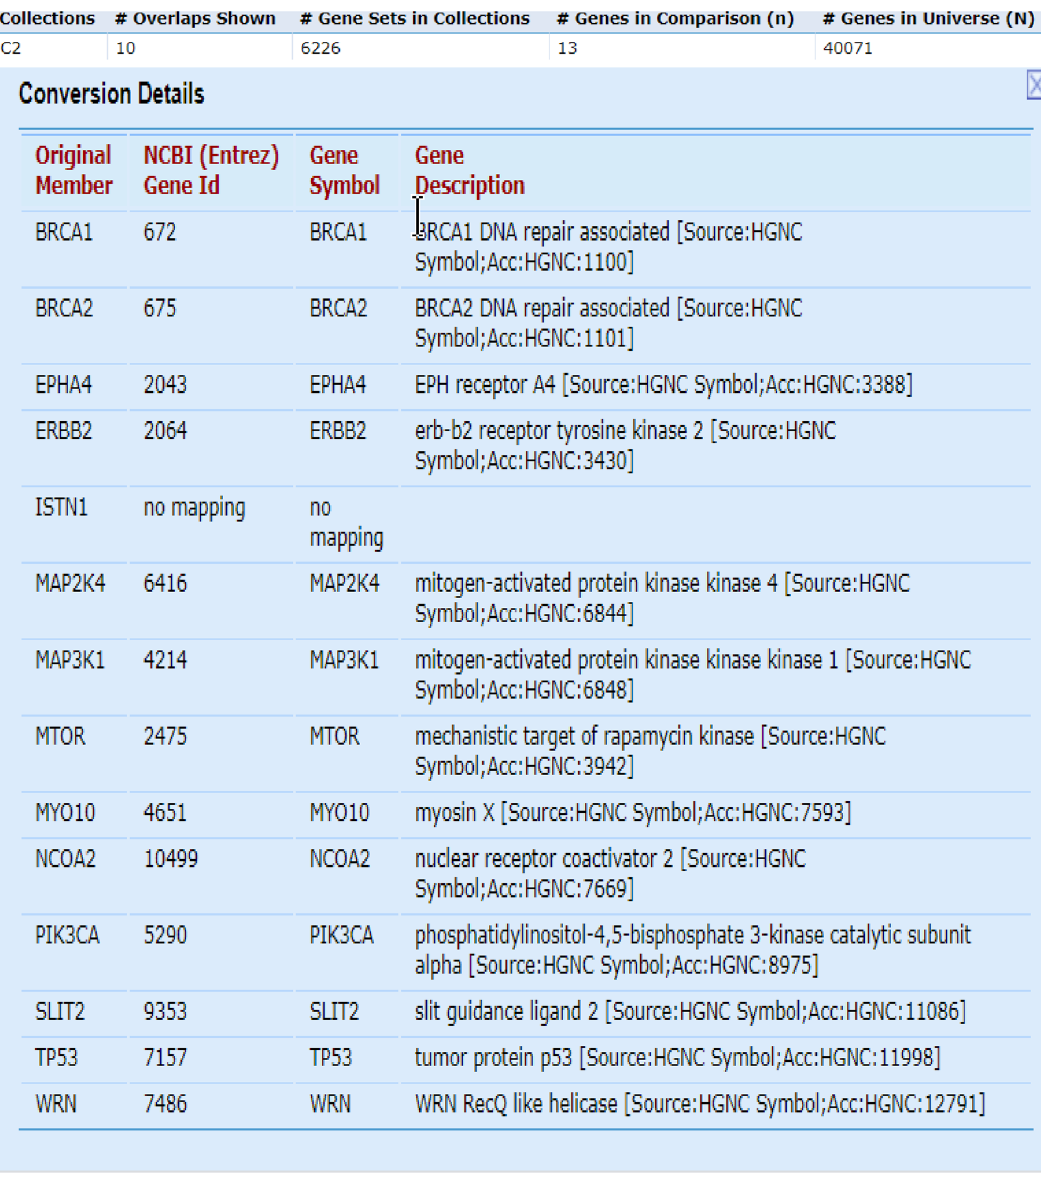
Figure 1. Details of 13 top driver genes in the proposed